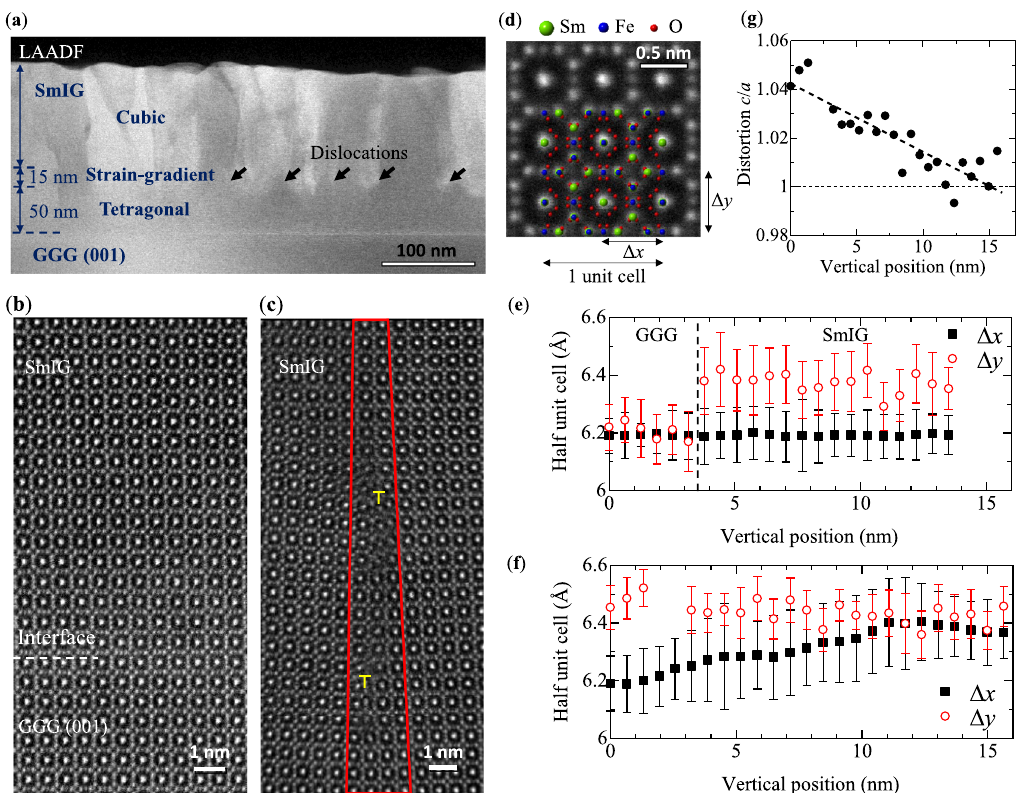
Fig. 2 STEM analysis of 180 nm-thick SmIG fi lm. a Micrometer-scale LAADF-STEM image. Dislocations are denoted by arrows. b Nanometer-scale HAADF-STEM image around the SmIG/GGG interface. c Nanometer-scale HAADF-STEM image around dislocations. d STEM image near the interface of SmIG fi lm overlaid with atomic model of garnet crystal structure. The lateral and vertical lengths of the half-unit cell are de fi ned as Δ x and Δ y . e Variations in Δ x and Δ y (mean ± s.d.) at different vertical positions quanti fi ed from Fig. 2(b). The dotted line represents the SmIG/GGG interface. f Variations in Δ x and Δ y (mean ± s.d.) at different vertical positions quanti fi ed from Fig. 2(c). The region surrounded by red lines in Fig. 2(c) was excluded from